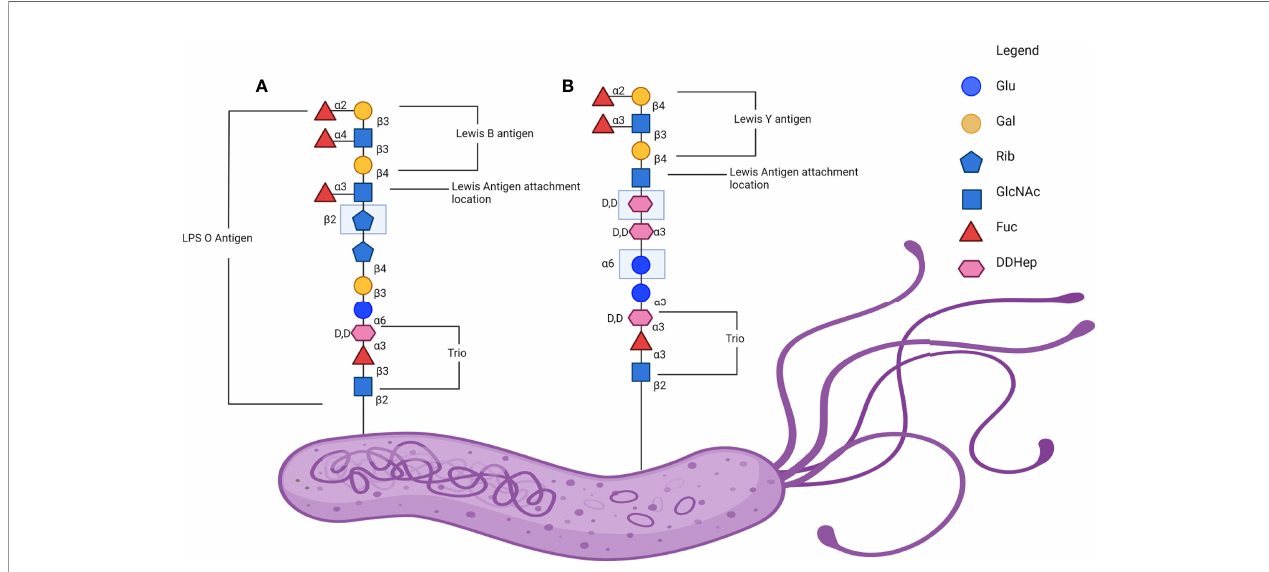
FIGURE 3 | Lewis antigen expression on H. pylori lipopolysaccharide (LPS) O antigen. (A) A representative linear glycan chain of the H. pylori SS1 strain O antigen with the Le b in comparison to (B) a representative linear glycan chain of H. pylori 26695 and G27 O antigen with the Le y antigen attached. Adapted from the established structure in Li et al., 2018. Note that the exact structure and the Lewis determinate expressed is variable and dependant on isolate (115). Created with